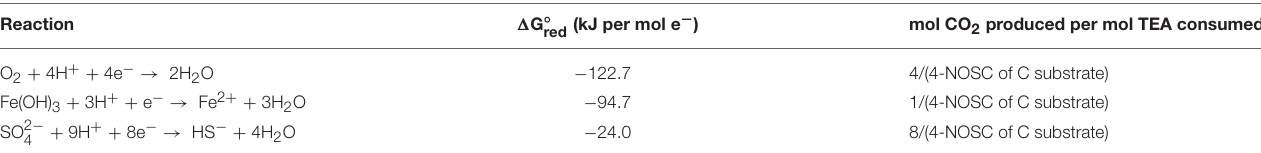
TABLE 2 | Half-reactions for reduction of terminal electron acceptors (TEA) considered for the respiration calculations with Gibbs free energy (kJ per mol e − ) from Arndt et al. (2013) and stoichiometric relation to oxidized C, assuming complete oxidation to CO 2 .